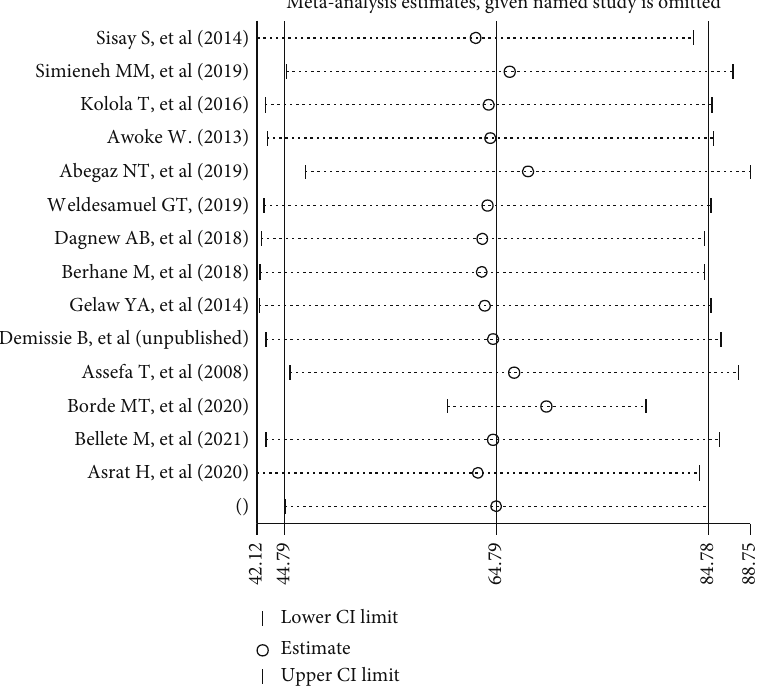
Figure 7: Sensitivity analysis of pooled prevalence for each study being removed one at a